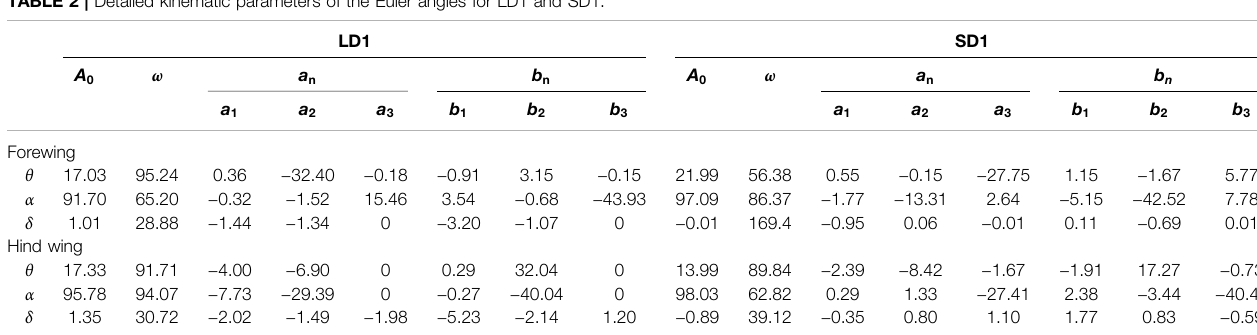
TABLE 2 | Detailed kinematic parameters of the Euler angles for LD1 and SD1.